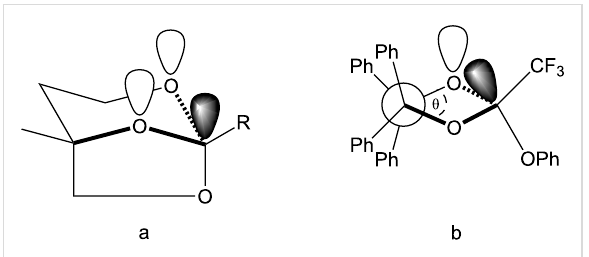
Figure 2: Stereoelectronic contributions to hydrolysis; (a) conforma- tionally constrained 1,3-dioxane orthoester; (b) Newman projection of five-membered ZICMED viewed C(4) → C(5).